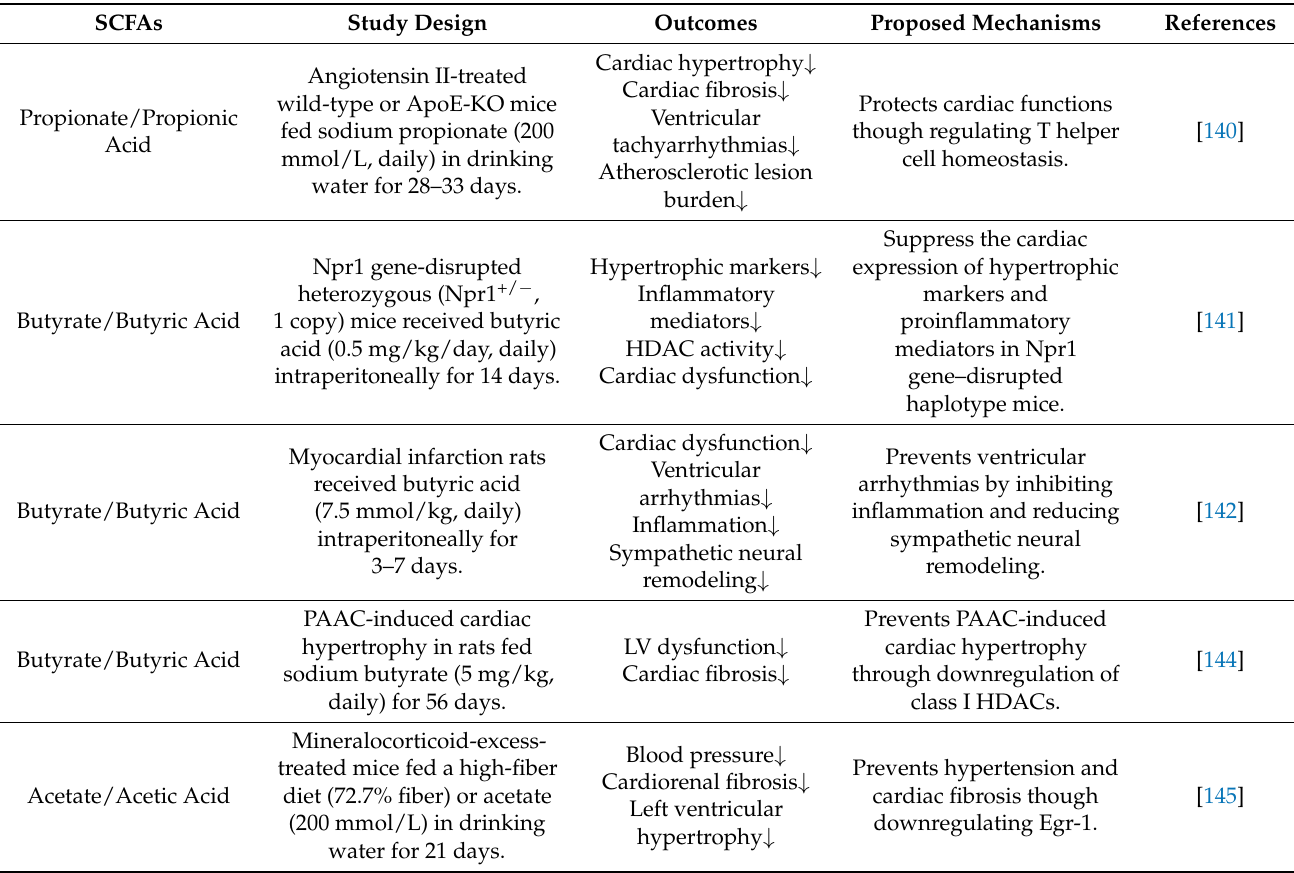
Table 2. Therapeutic effects of short-chain fatty acids (SCFA) on cardiovascular